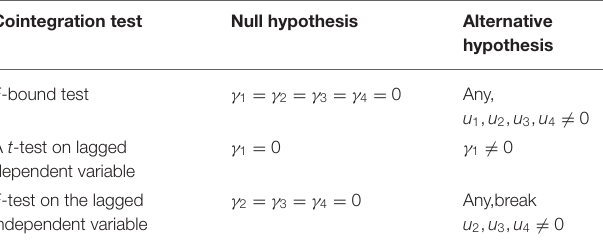
TABLE 2 | The definition of null hypotheses for all three tests. Cointegration